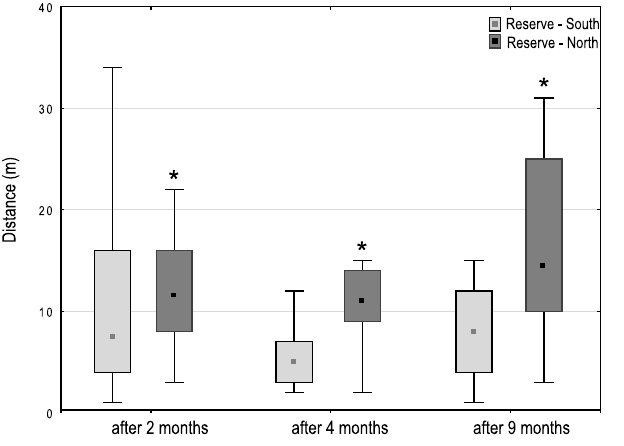
Fig 5. Mean linear distances travelled by tagged trochus within the Takara reserve. Medianwith 25– 75% percentile and results of two-way ANOVA after 2, 4 and 9 months ( * p < 0.05).